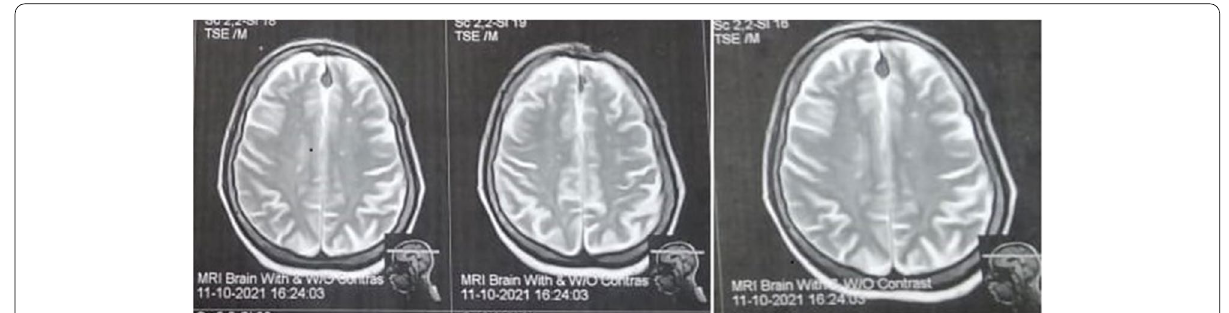
Fig. 3 Multiple parietal deep white matter foci suggestive of vasculitis versus